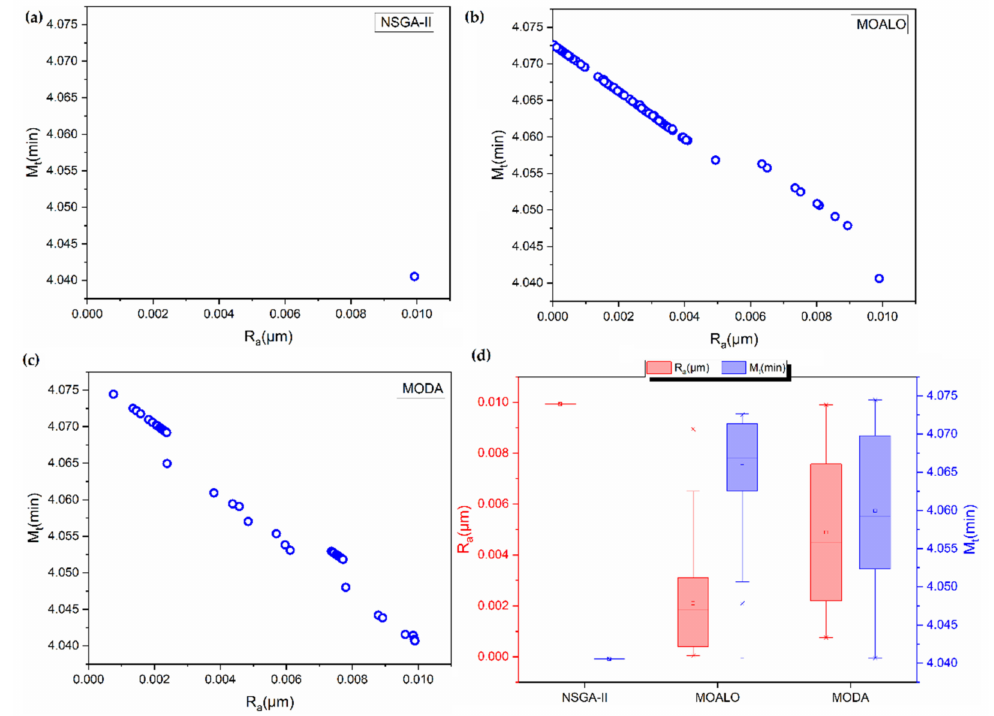
Figure 3. Pareto fronts for optimization of micro-milling process of 700 µ m size slot using ( a ) NSGA-II ( b ) MOALO ( c ) MODA. ( d ) Box plot showing the spread of the Pareto